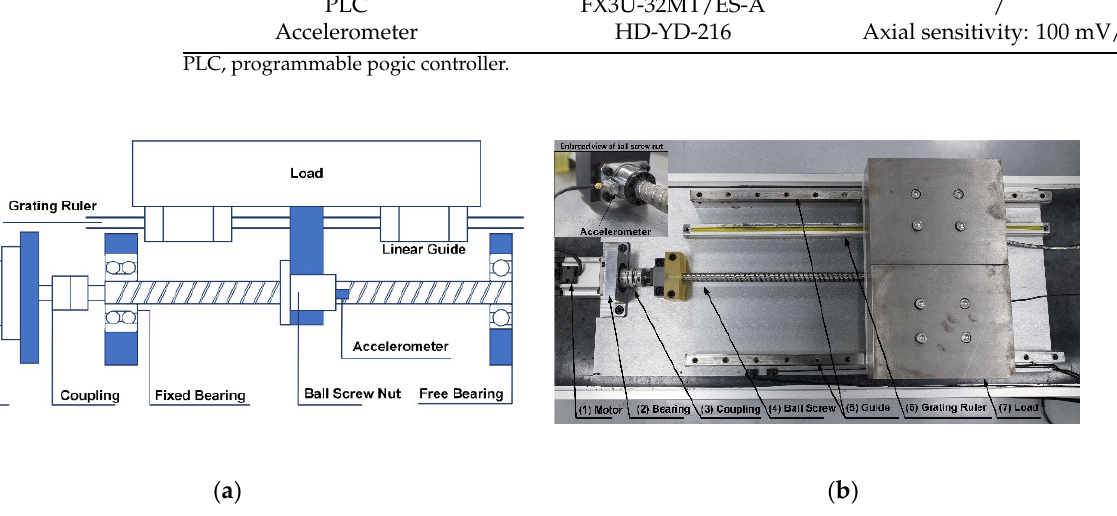
Table 6. Specification of the ball screw test platform.